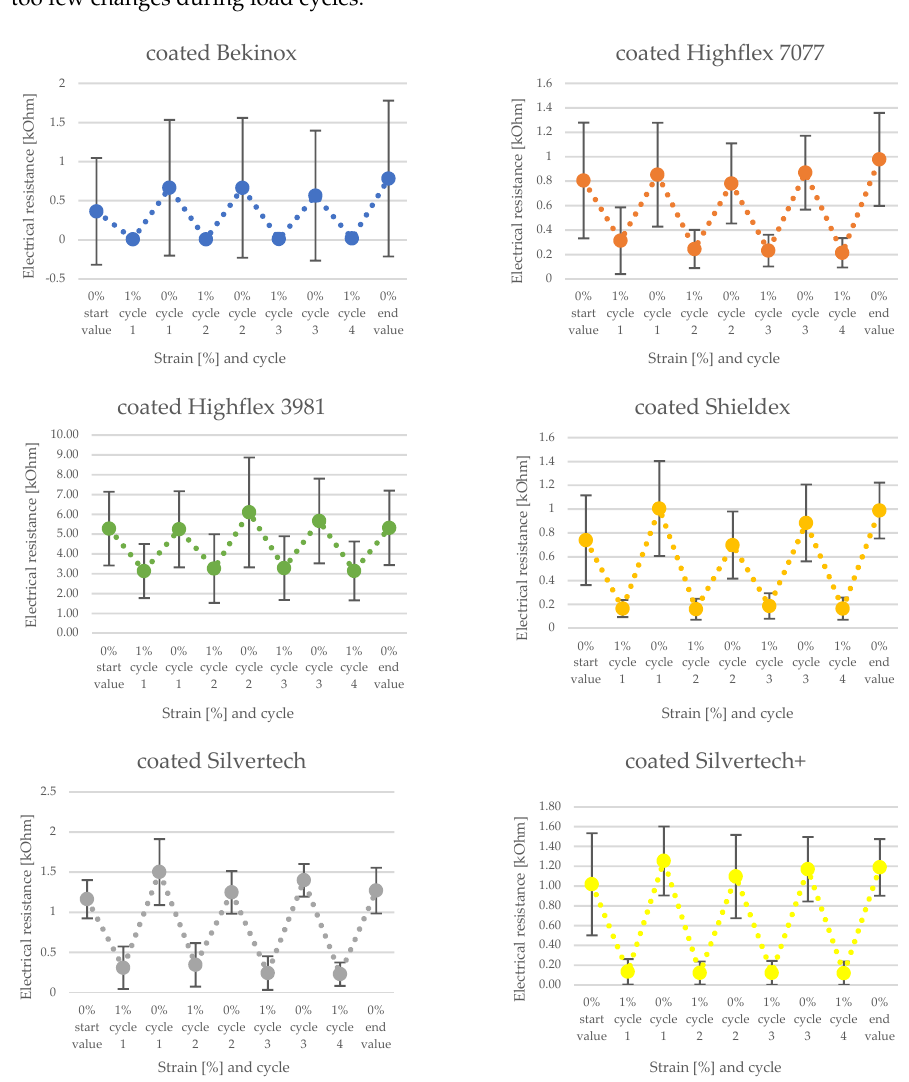
Figure 10. Single display of change of electrical resistance of coated substrates with standard devia- tion.